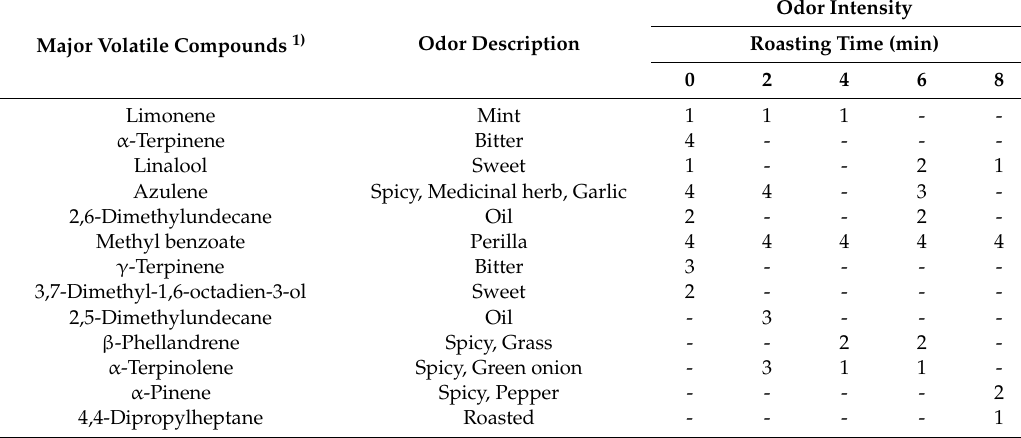
Table 2. Sensory description and odor intensity of P. frutescens Britton var. acuta Kudo during the roasting using